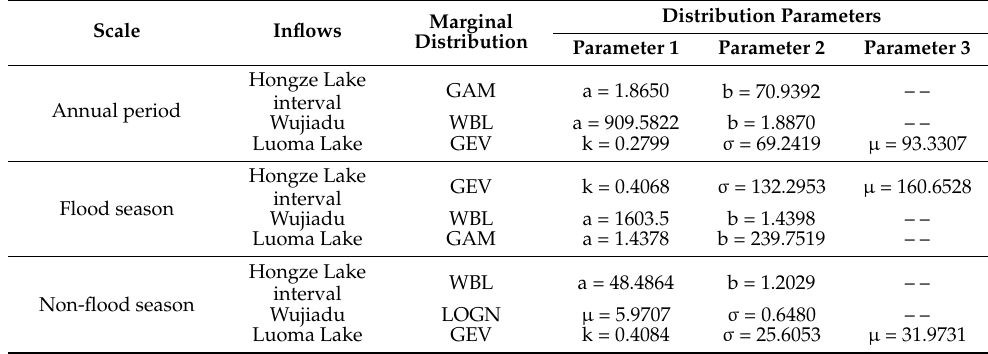
Table 3. Scheme I of the marginal distributions and their distribution parameters. Distribution Scale Inflows Marginal Distribution